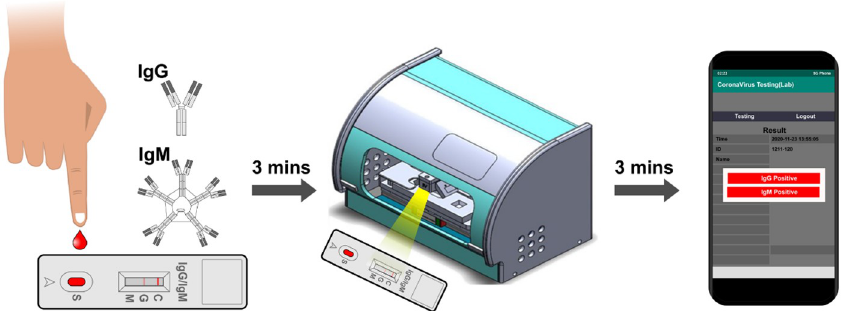
Fig 3. The workflow of quantitative spectral LFIA platform. The optical-based platform applies 10–20 uL of blood from a fingertip or a vein to the test strip, integrating the immunoglobulins and producing results in 5–10 minutes.